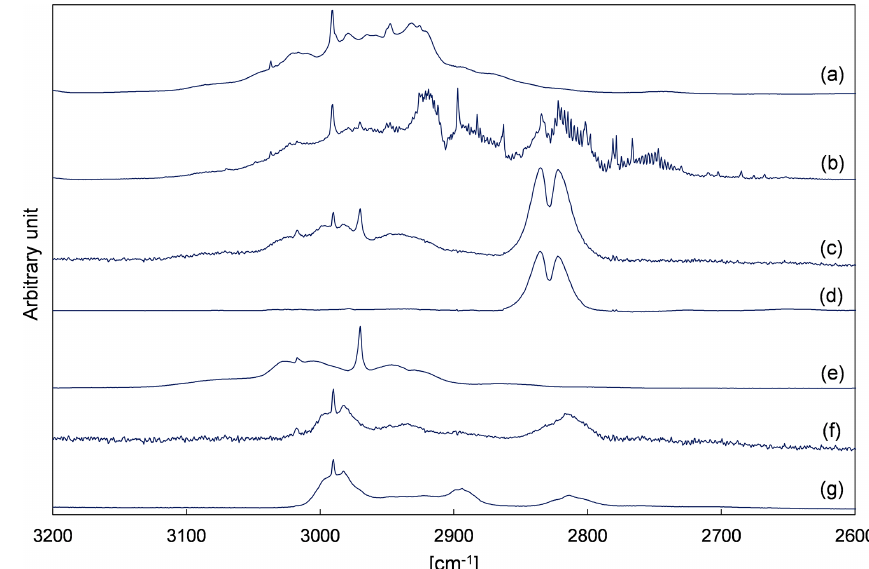
Figure 4. Exemplary FTIR spectra of a product study experiment of 4M3P2 + OH: (a) reaction mixture before irradiation; (b) reaction mixture at the end of the irradiation period; (c) residual spectrum after subtraction of 4M3P2, methyl nitrite, methyl nitrate, HONO, HNO 3 , NO, NO 2 and HCHO from (b) ; (d) reference spectrum of methyl glyoxal; (e) reference spectrum of acetone; (f) residual spectrum after subtracting methyl gyloxal, acetone and PAN from (c) ; and (g) reference spectrum of 2-hydroxy-2-methylpropanal generated in situ. The spectra are shifted and scaled individually for a better overview.